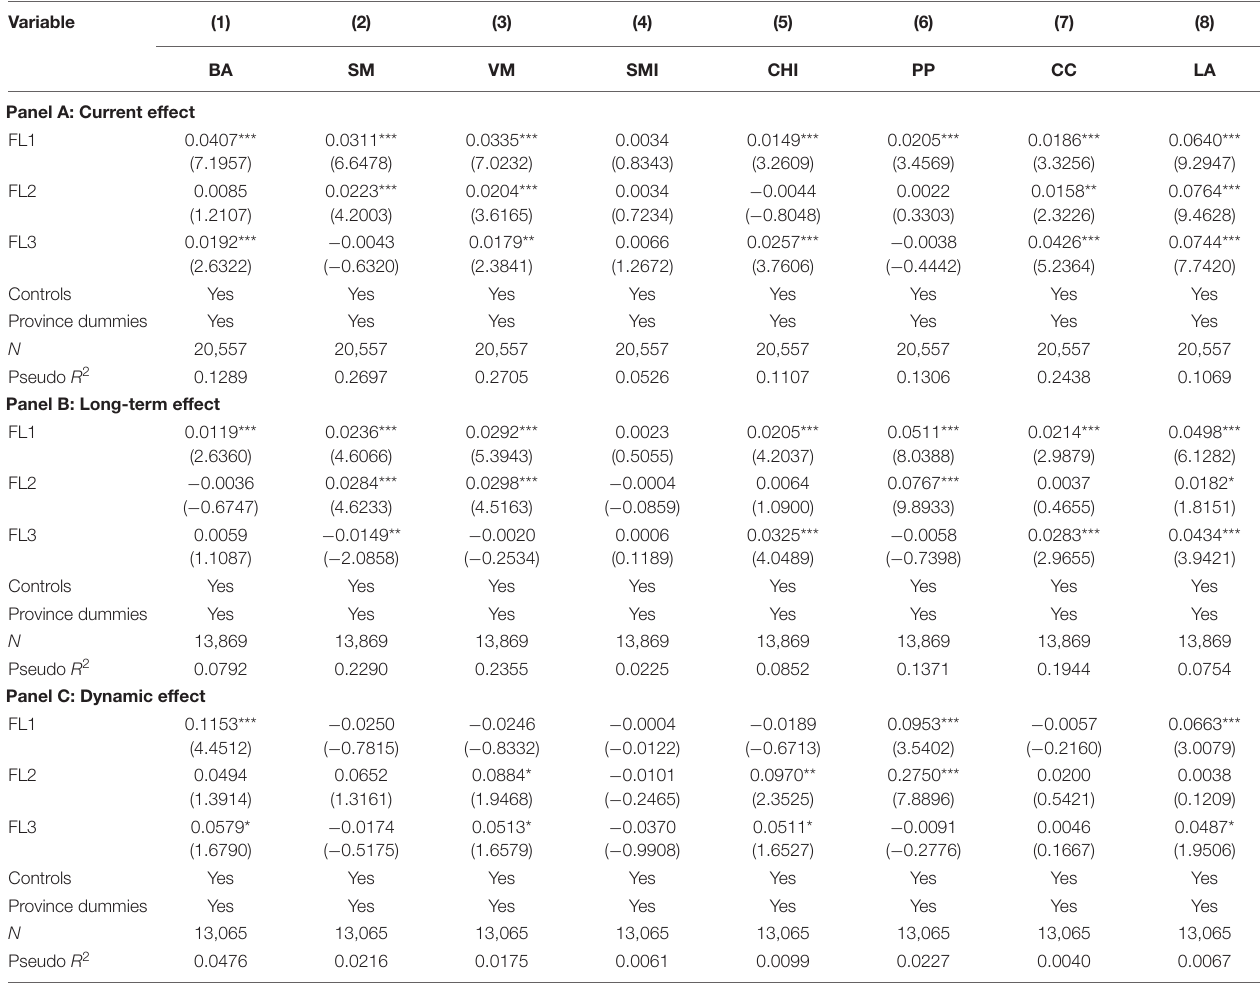
TABLE 8 | Robust test by considering subitem of financial